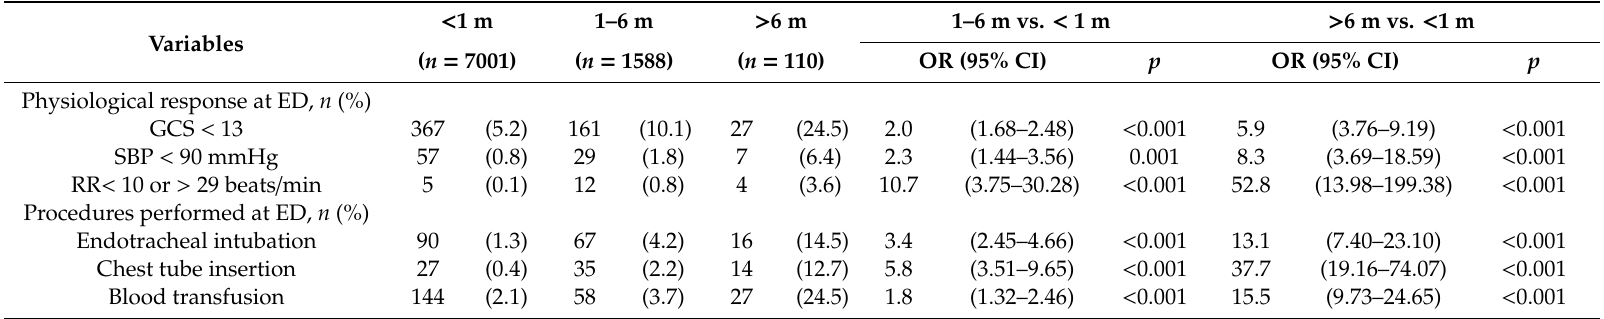
Table 3. Physiological response of the patients and procedures performed at the emergency department after falls from di ff erent height.